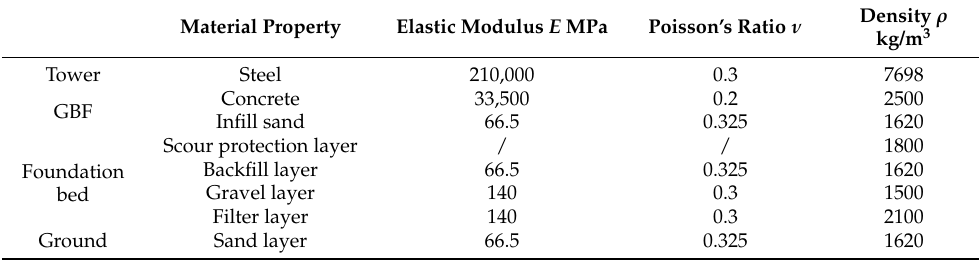
Table 2. Material properties of the OWT on the GBF